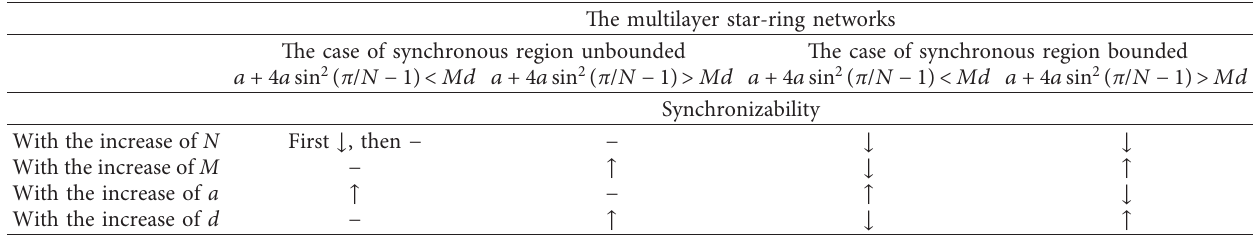
Table 4: When d � d , the synchronizability of the multilayer star-ring networks varies with N , a , d , and M . 0 The multilayer star-ring networks